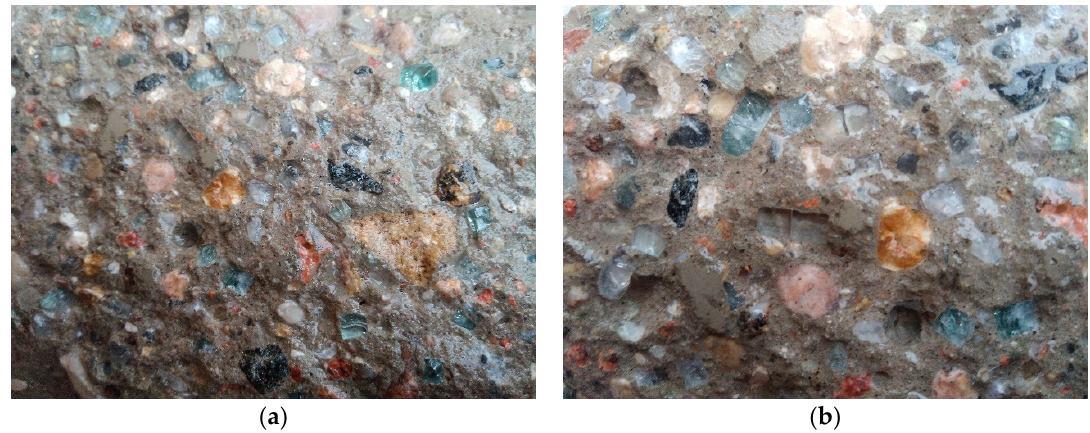
Figure 10. The fracture surface of the RGA concrete: ( a , b ) various fragments of the surface.